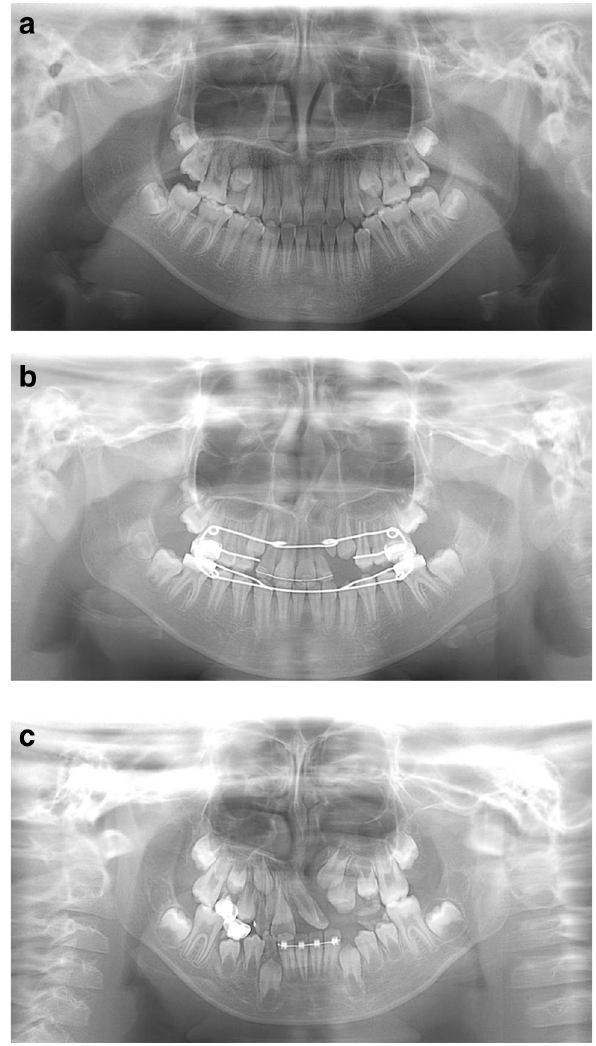
Figure 3. The findings of the inferior line of the piriform aperture were divided into three types. (a) is “clear and equivalent level”, (b) is “clear and inferior level”, and (c) is “obscure or